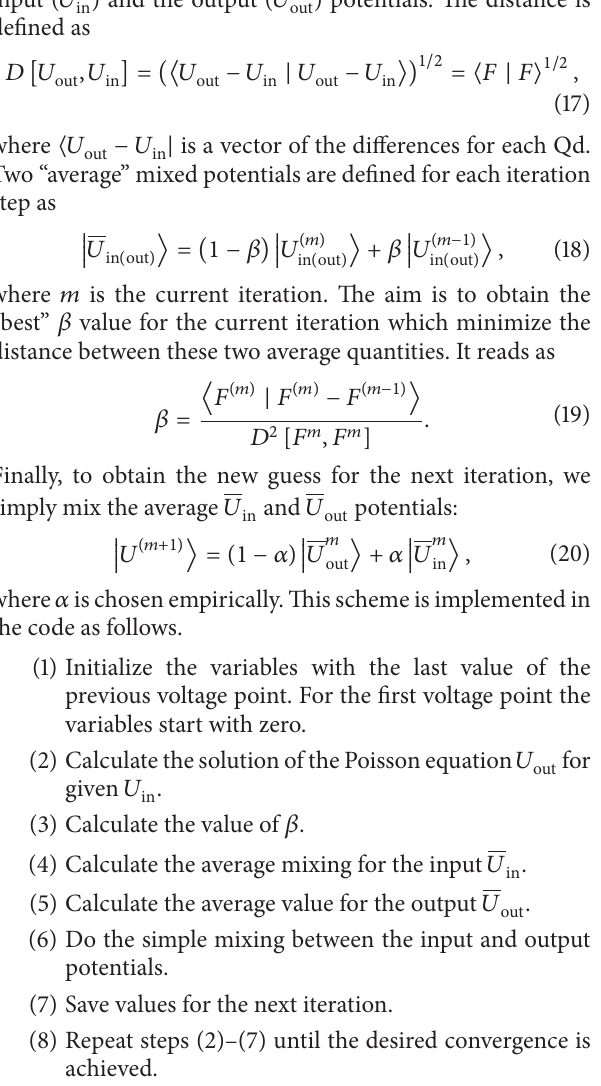
Table 1: Parameters used in the simulation in order to describe Si Qds embedded in SiO 2 insulator matrix. 𝑚 0 and 𝜀 0 are the free electron mass and the vacuum permittivity,